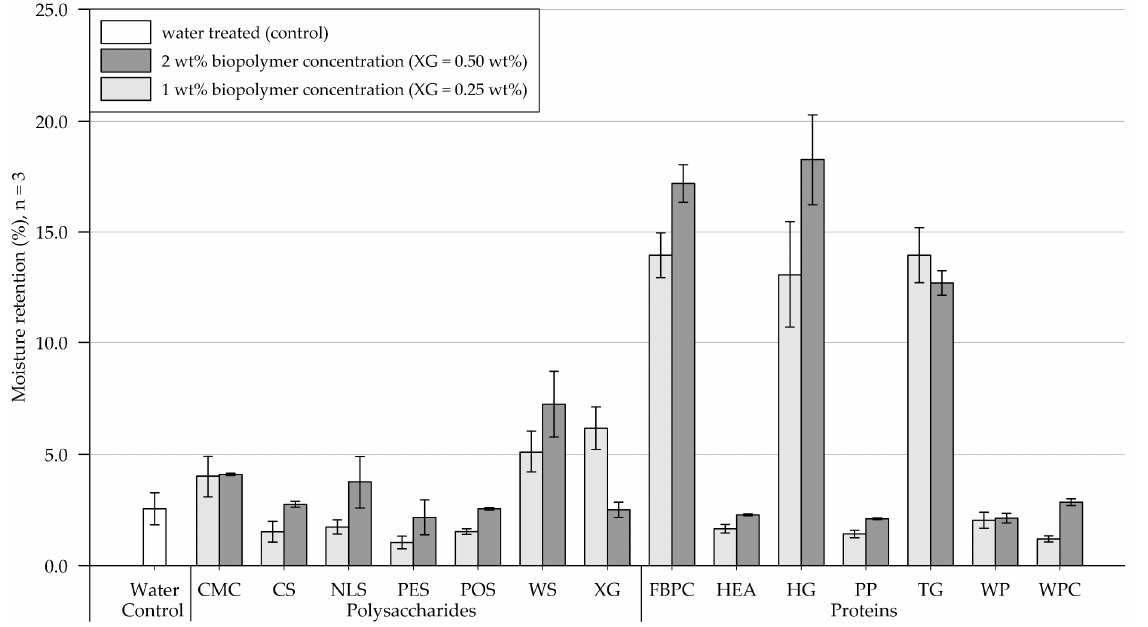
Figure 6. Mean moisture retention of fine-grained silica sand samples 4 days (96 h) after treatment at 1.6 L/m² and biopolymer concentrations of 1 and 2 wt% (XG = 0.25 and 0.50 wt%). Biopolymers are grouped into polysaccharides and proteins with water as control. Tests were performed in triplicates ( n = 3), and error bars indicate the standard deviation (SD). Note. The exact values of experimental results are appended in Table A2.